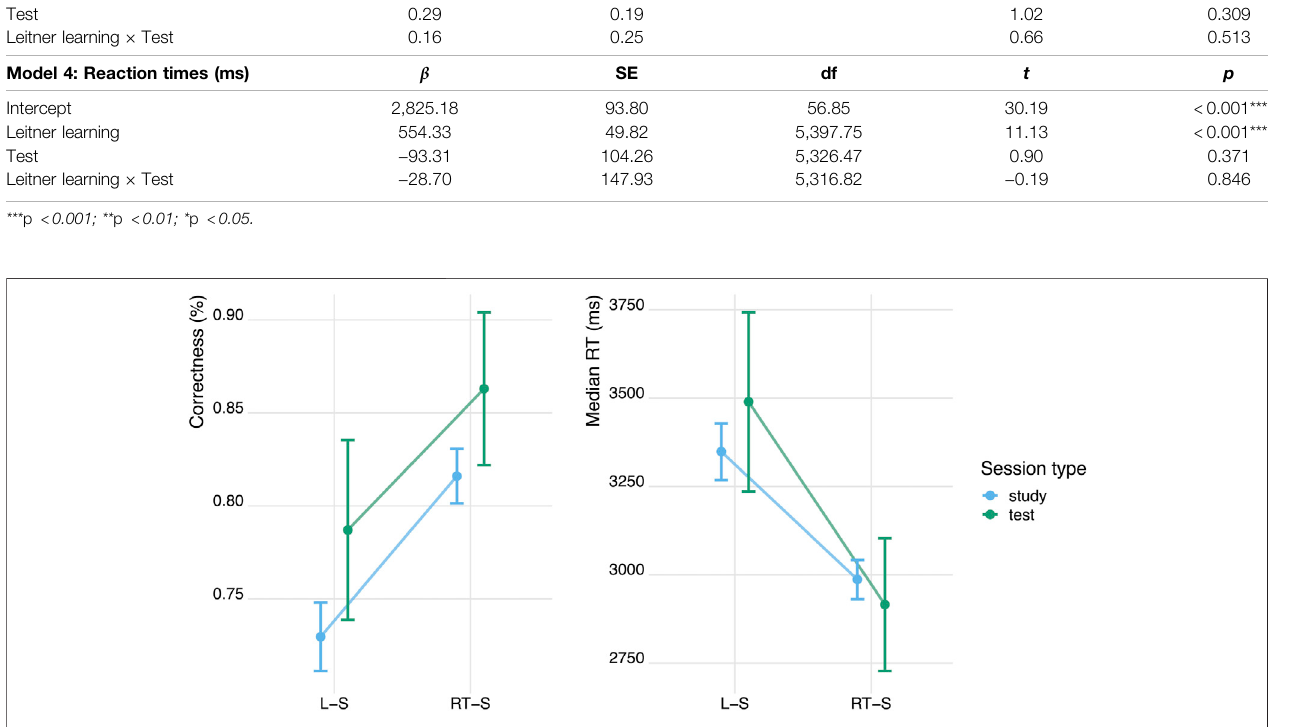
Frontiers in Arti fi cial Intelligence |